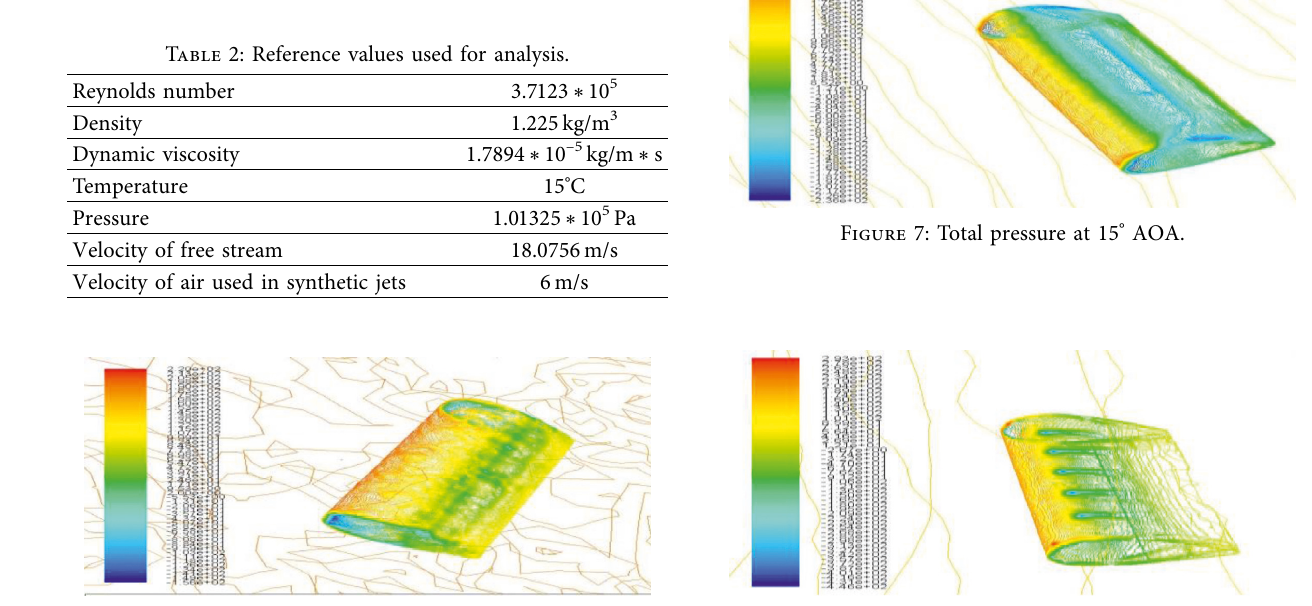
Figure 5: Total pressure at 0 ° AOA.